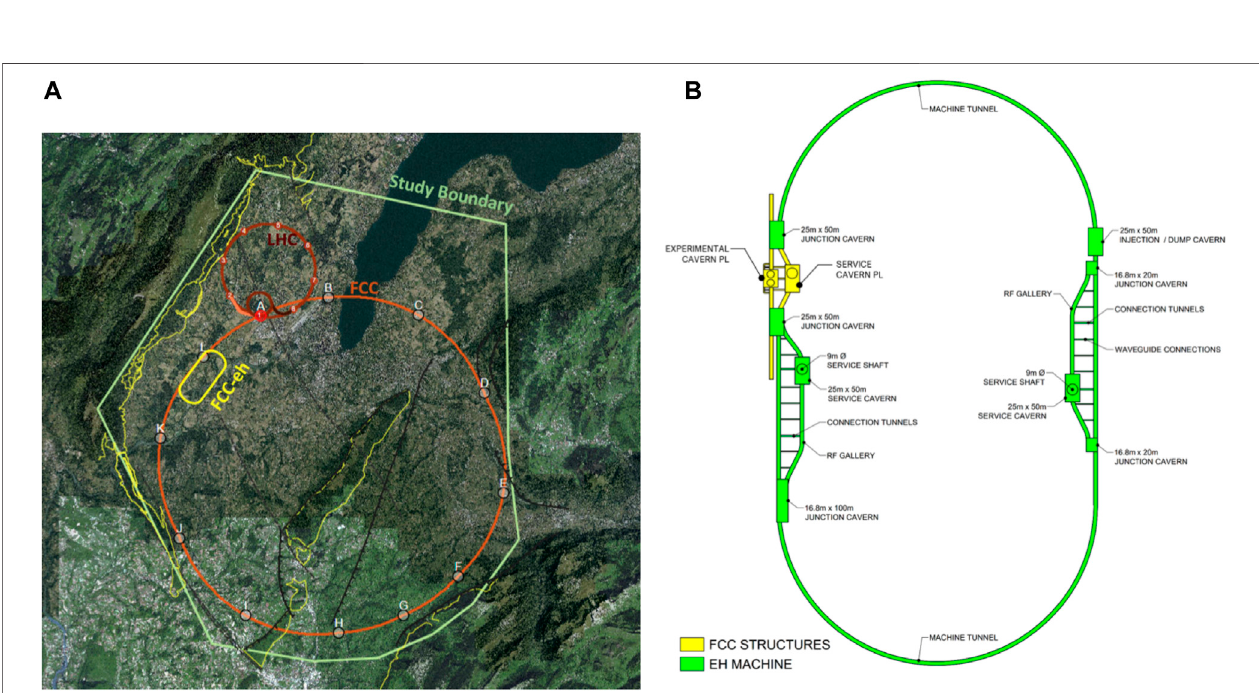
FIGURE 3 | FCC-eh layout and underground structures of the FCC-eh. (A) The FCC-eh layout next to the FCC and LHC infrastructures. The yellow lines indicate the ERL of the FCC-eh, the light red lines the FCC installation and the dark red the existing LHC tunnel. (B) Schematic layout of the ERL underground structures for the